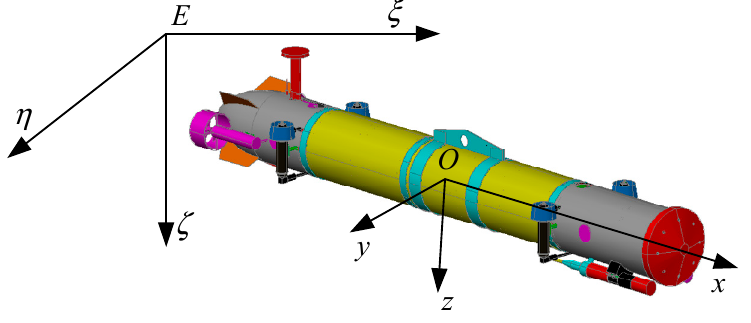
Figure 7. Body-fixed frame and inertial reference frame.